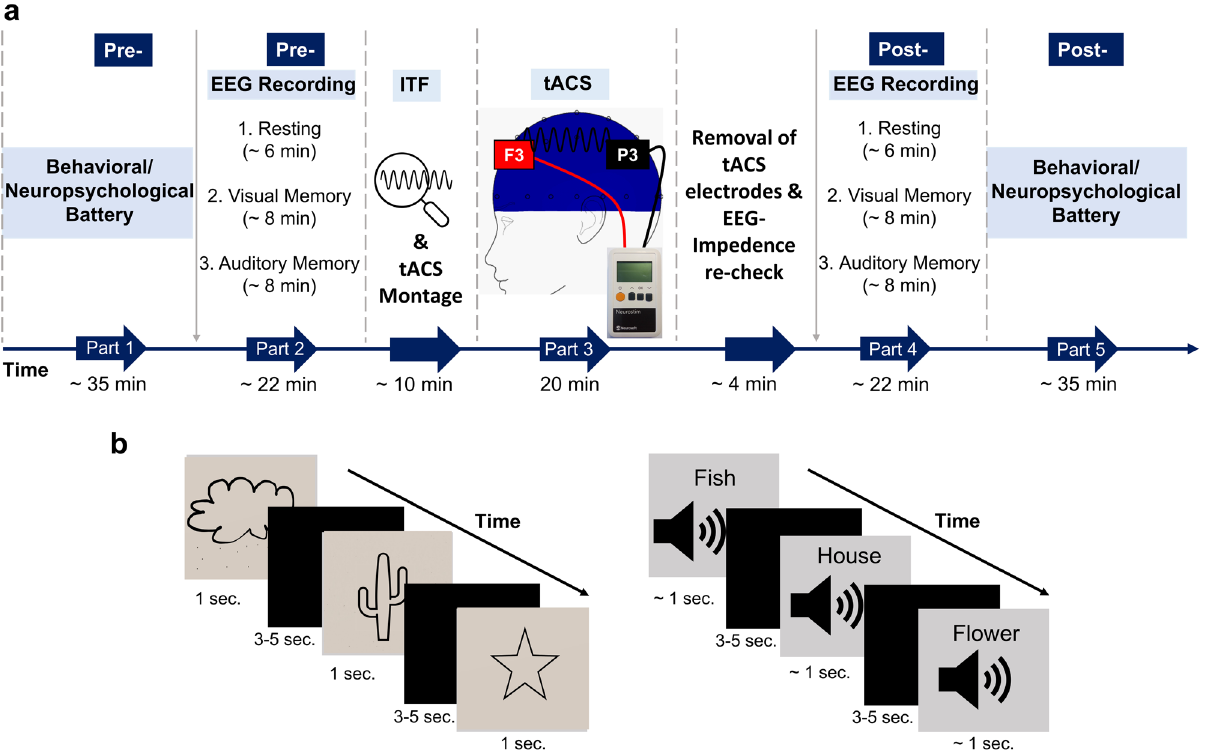
Figure 4. Experimental design and task procedure. ( a ) Design of the experiment. The “part” states each experimental phase. The horizontal dark blue arrow shows the time-course and application order of the parts with durations of them in minutes. The vertical grey arrows show the application order of the numbered measurements stated in the part. ( b ) The representations of the applied visual* (on the left) and auditory (on the right) memory tasks during the EEG recordings. * Given schematic images in Fig. 4b are not actual exemplars from the Boston naming test set; drawn by TA as an example. tACS, transcranial alternating current stimulation; ITF, individual theta frequency; min, minute; sec.,